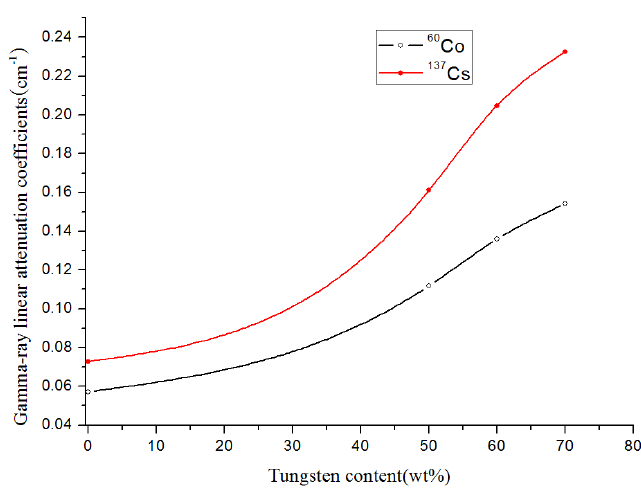
Figure 19. Comparison of attenuation characteristics of 137 C S and 60 Co sources.